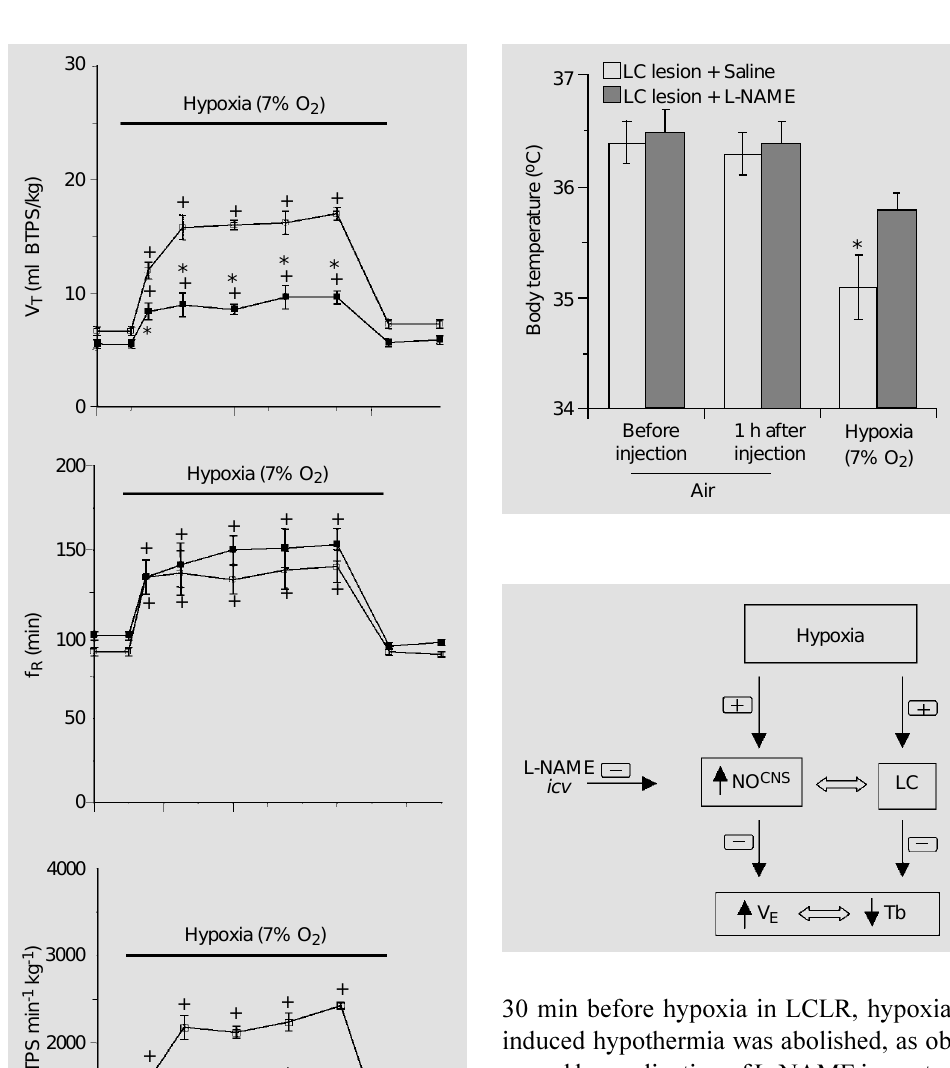
Figure 7 - Combined effect of hypoxia and intracerebroven- tricular injection of N G -nitro-L- arginine methyl ester (L-NAME; 250 µg/µl) on body temperature of locus coeruleus (LC)-lesioned rats that received an icv injec- tion of saline (N = 5) or L-NAME (N = 7). Values are reported as means ± SEM. *Significant drop (P<0.05) in body temperature